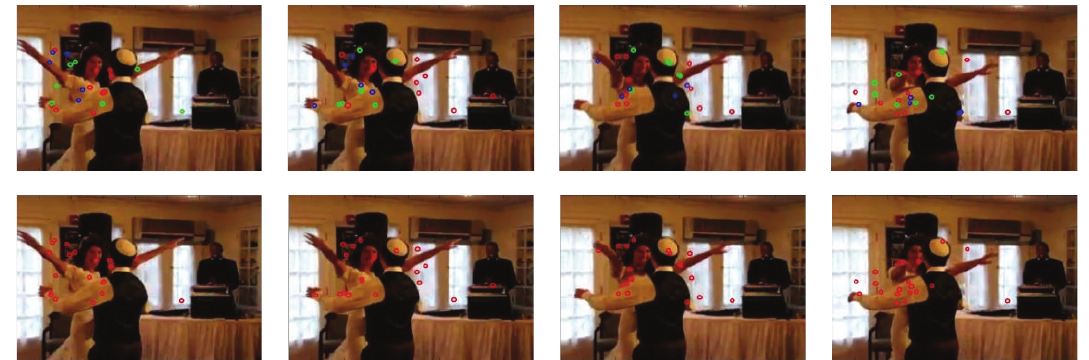
Figure 8: An example of high-level codewords which include only visual